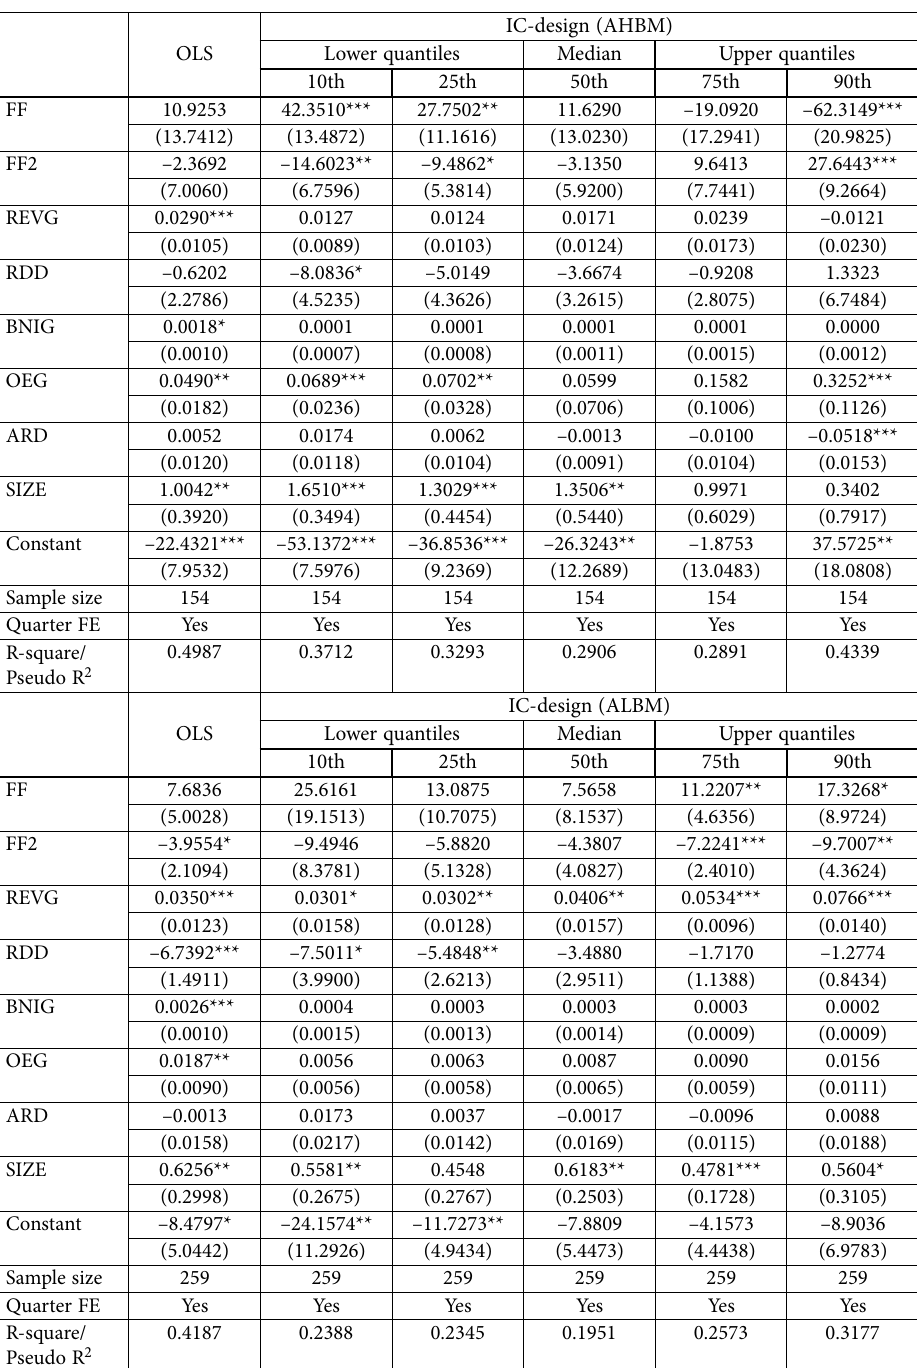
Table 9. OLS and QR results of AHBM and ALBM IC-design